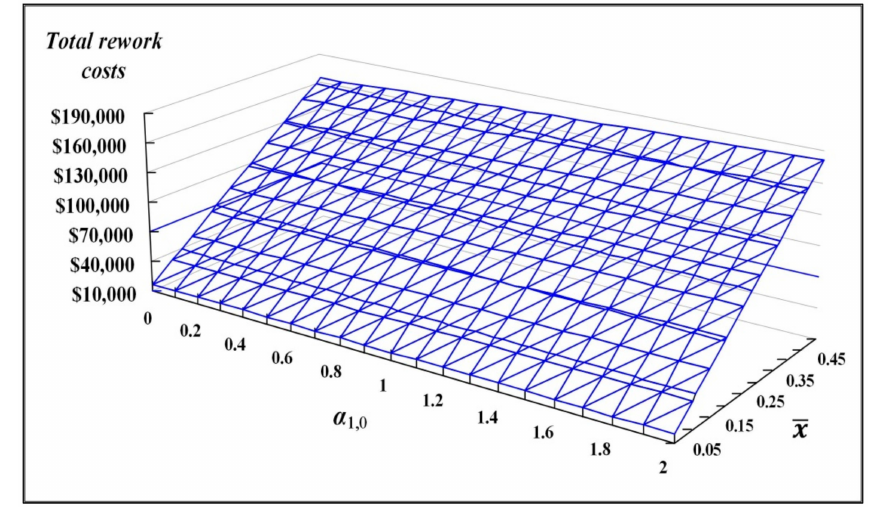
Figure 13. The collective impact of changes in α 1,0 and average nonconforming rate on total rework cost.